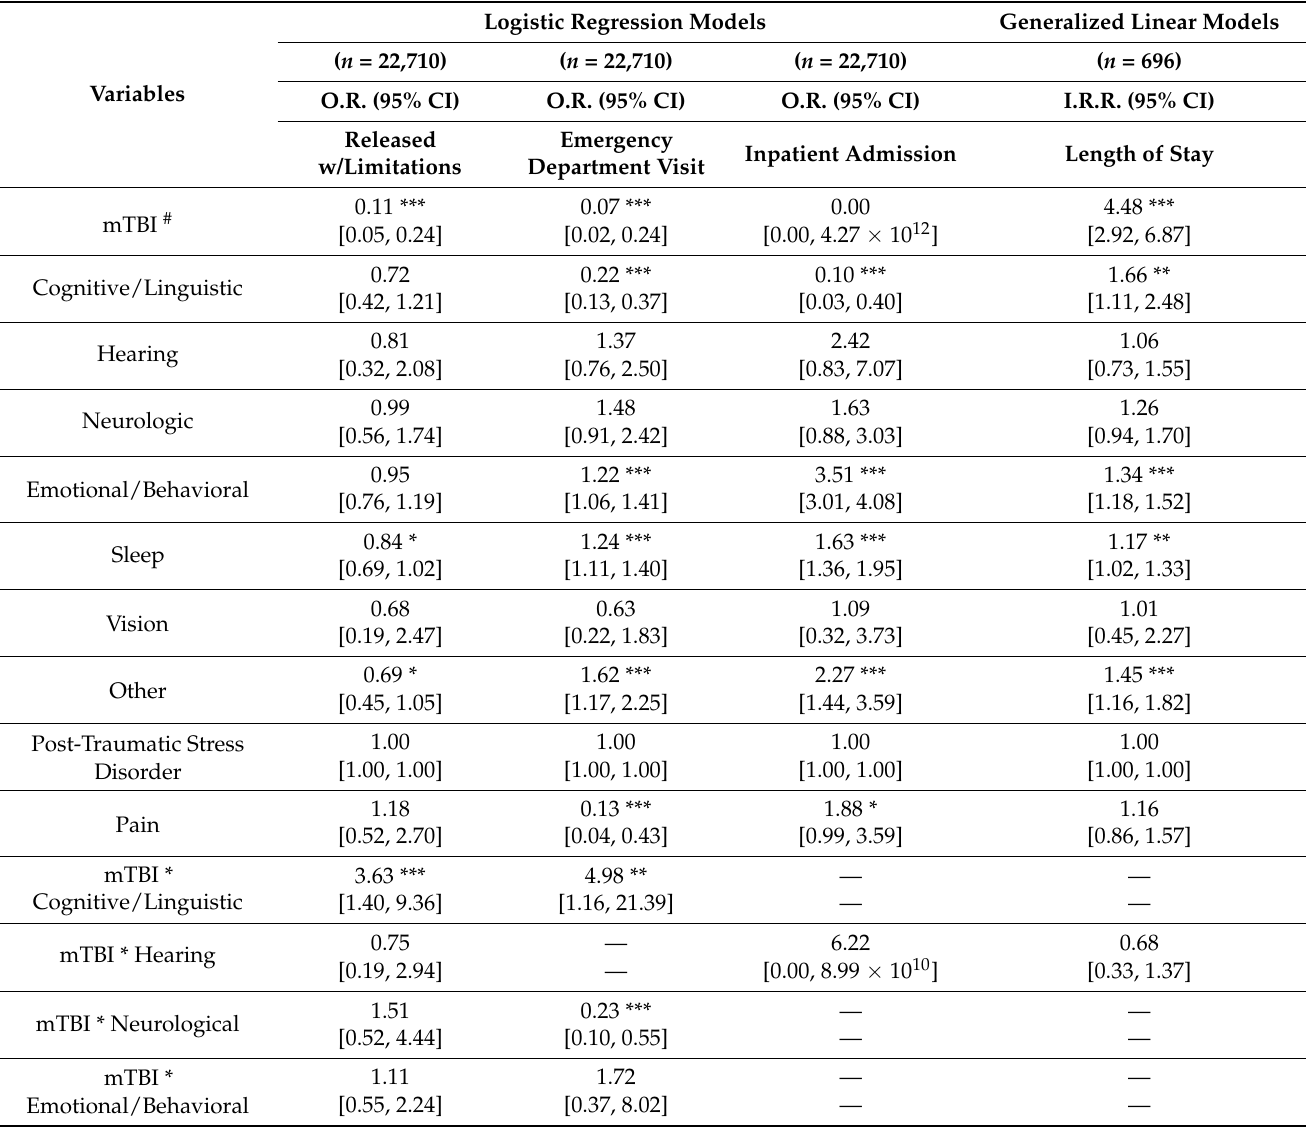
Table 3. Regression results for multivariate models for servicemembers with a history of deployment, Military Health System data repository, 2015–2019. Logistic Regression